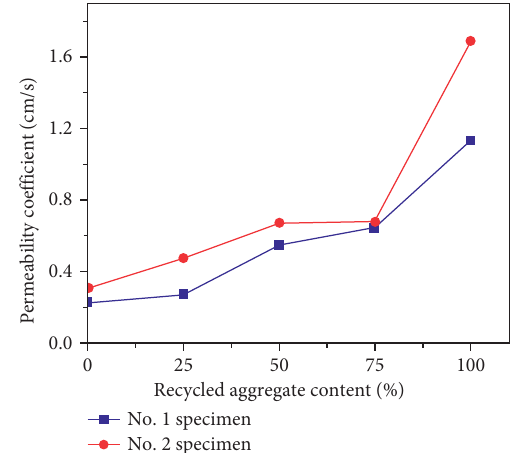
Figure 16: Relationship between water retention and evaporation time.